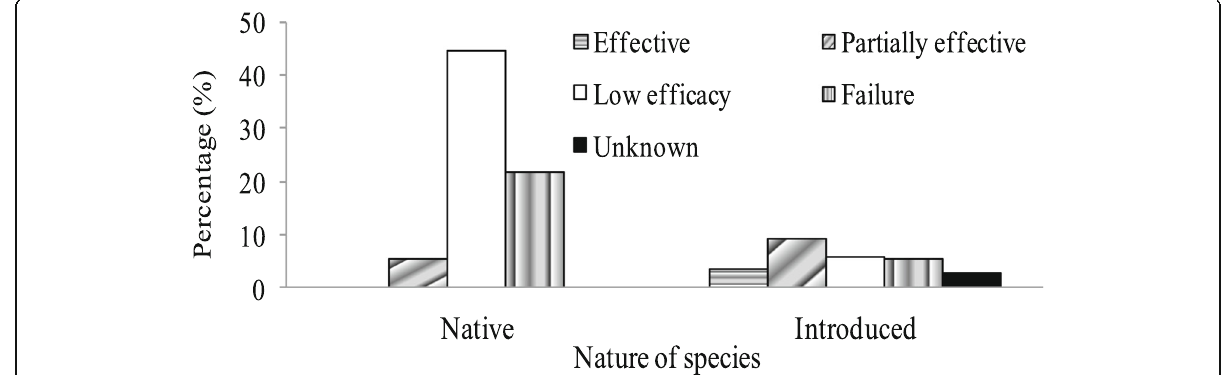
Fig. 5 Percentage of presence (%) of all beneficial according to their efficacy in Moroccan citrus orchard ( N = 105)